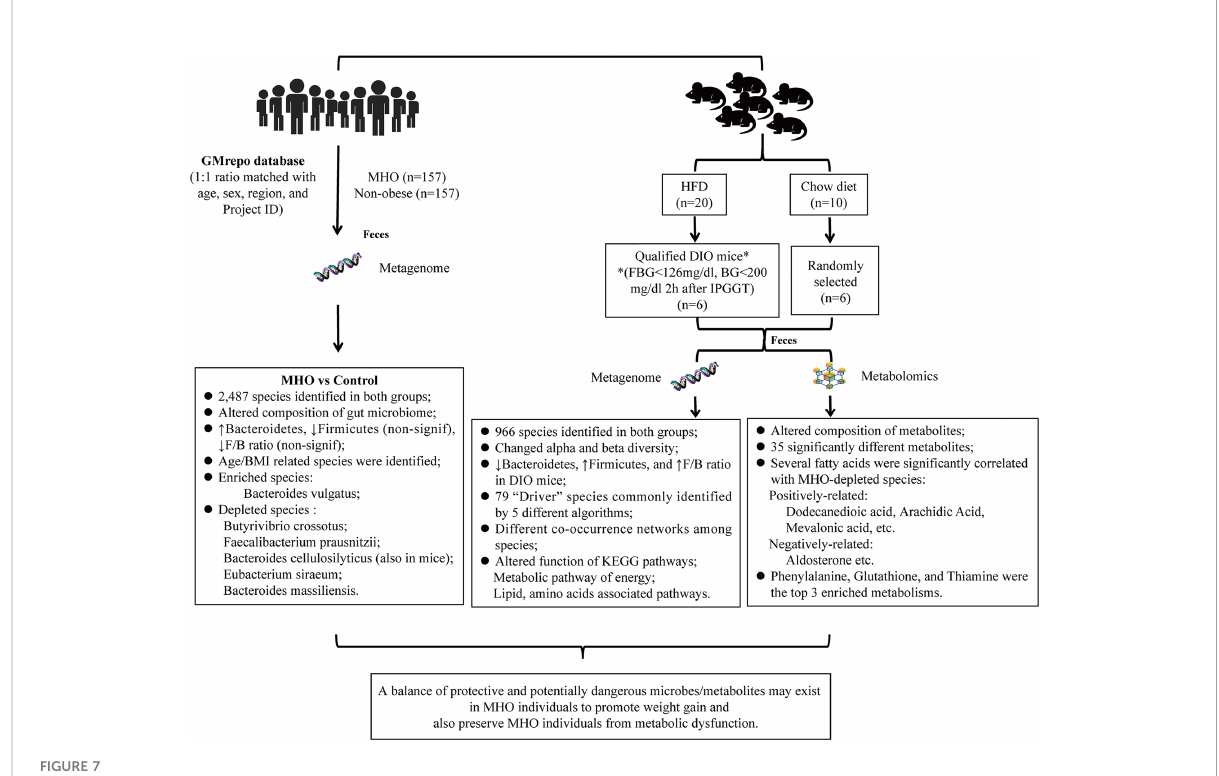
FIGURE 7 Summary of the